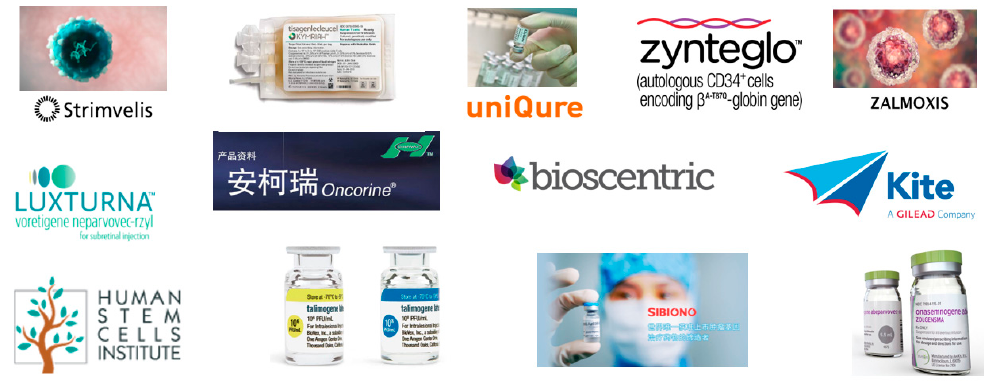
Figure 5. Some of the gene therapy-based products that have reached the clinical market.